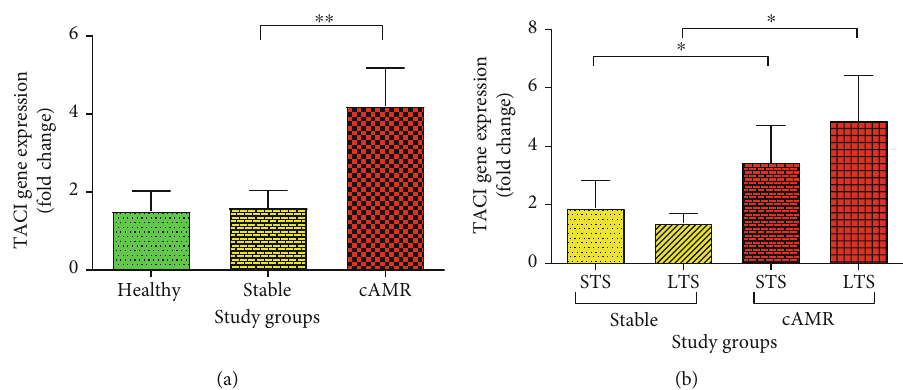
Figure 8: mRNA expression level of TACI in healthy individuals, patients with stable graft function, and cAMR patients (a). mRNA expression level of TACI in stable and cAMR patients with short-term survival (STS) and long-term survival (LTS) (b). Error bars represent SEM ( ∗ P ≤ 0 : 05 , ∗∗ P ≤ 0 : 01